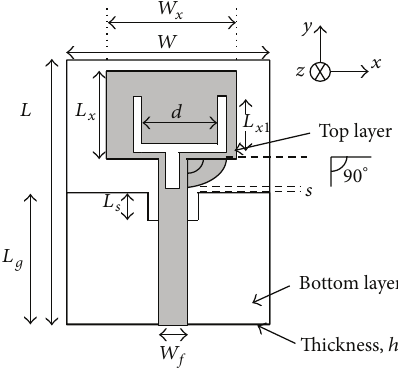
Figure 1: Geometry of the proposed notched antenna.